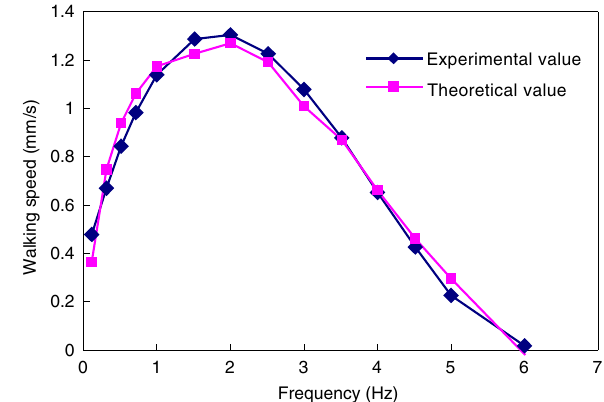
Figure 17 Relationship between calculation results and experimental results with one degree of freedom.